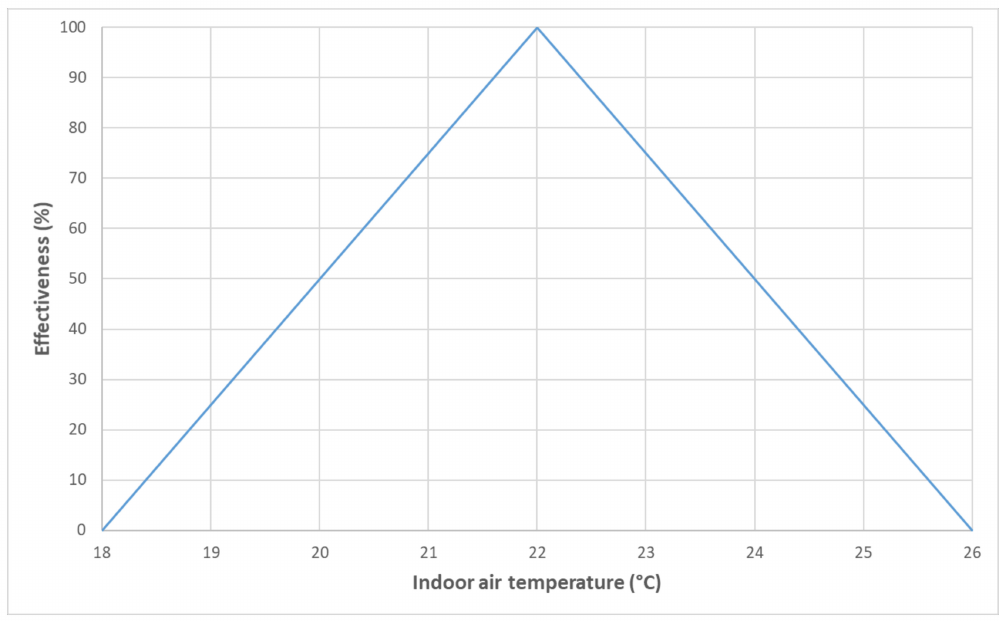
Figure 2. E ff ectiveness of the passive method for a temperature of comfort of 22 ◦ C.